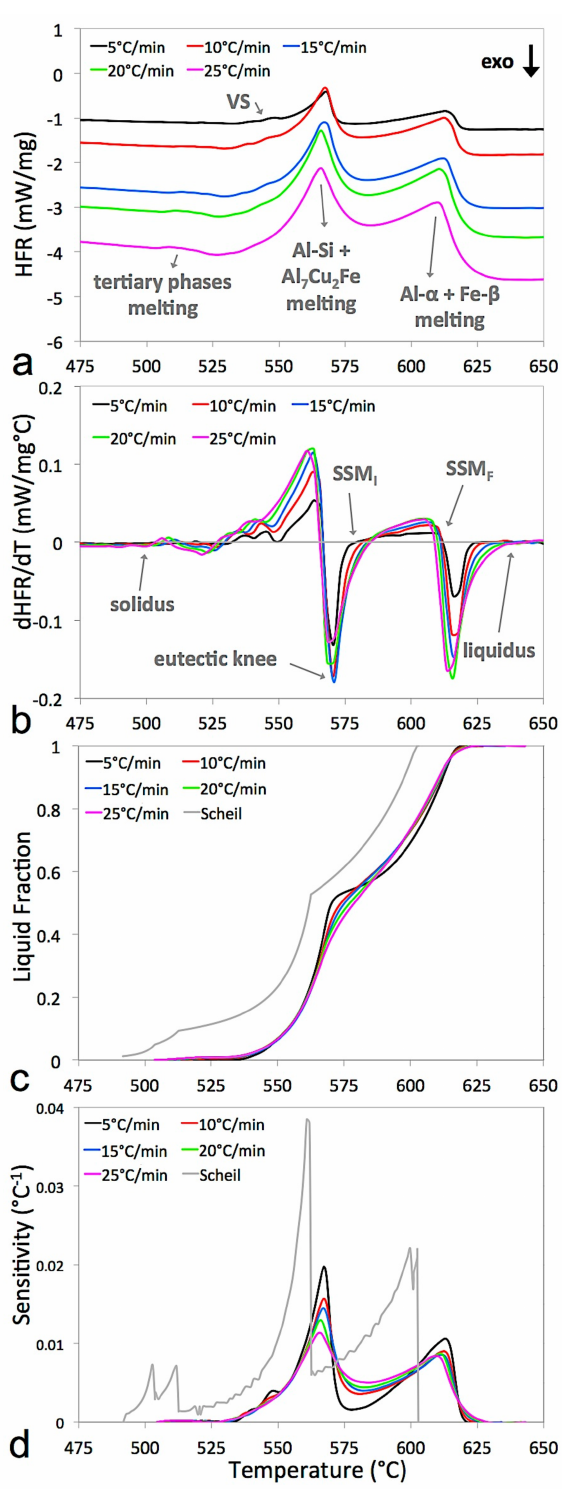
Figure 5. HFR ( a ), d HFR /d T ( b ), f l ( c ), and d f l /d T ( d ) vs. T curves for the B319+Fe alloy at several heating rates. The values predicted by numerical simulation under the Scheil conditions are shown for reference (grey curves). The arrows indicate phase transformations and temperatures of interest identified by the differentiation method (DM). The VS arrow indicates a “visible superposition” of phase transformations in the DSC